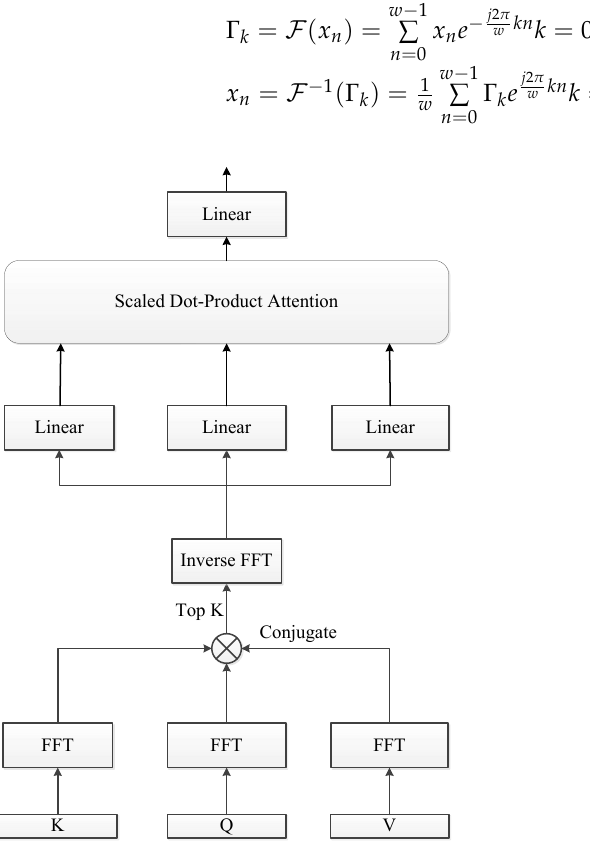
Figure 2. The proposed auto-attention